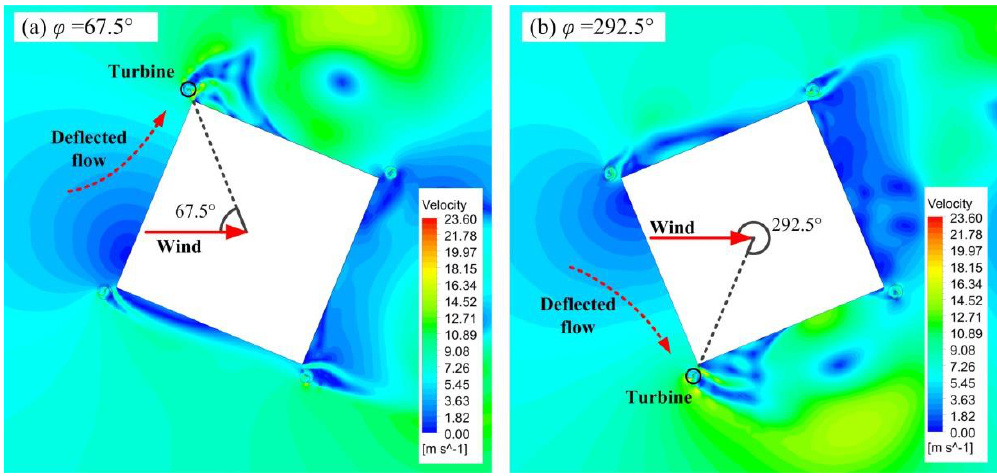
Figure 20. Velocity contours around the building at TSR = 1.2 and at ( a ) φ = 67.5° and ( b ) φ = 292.5°.